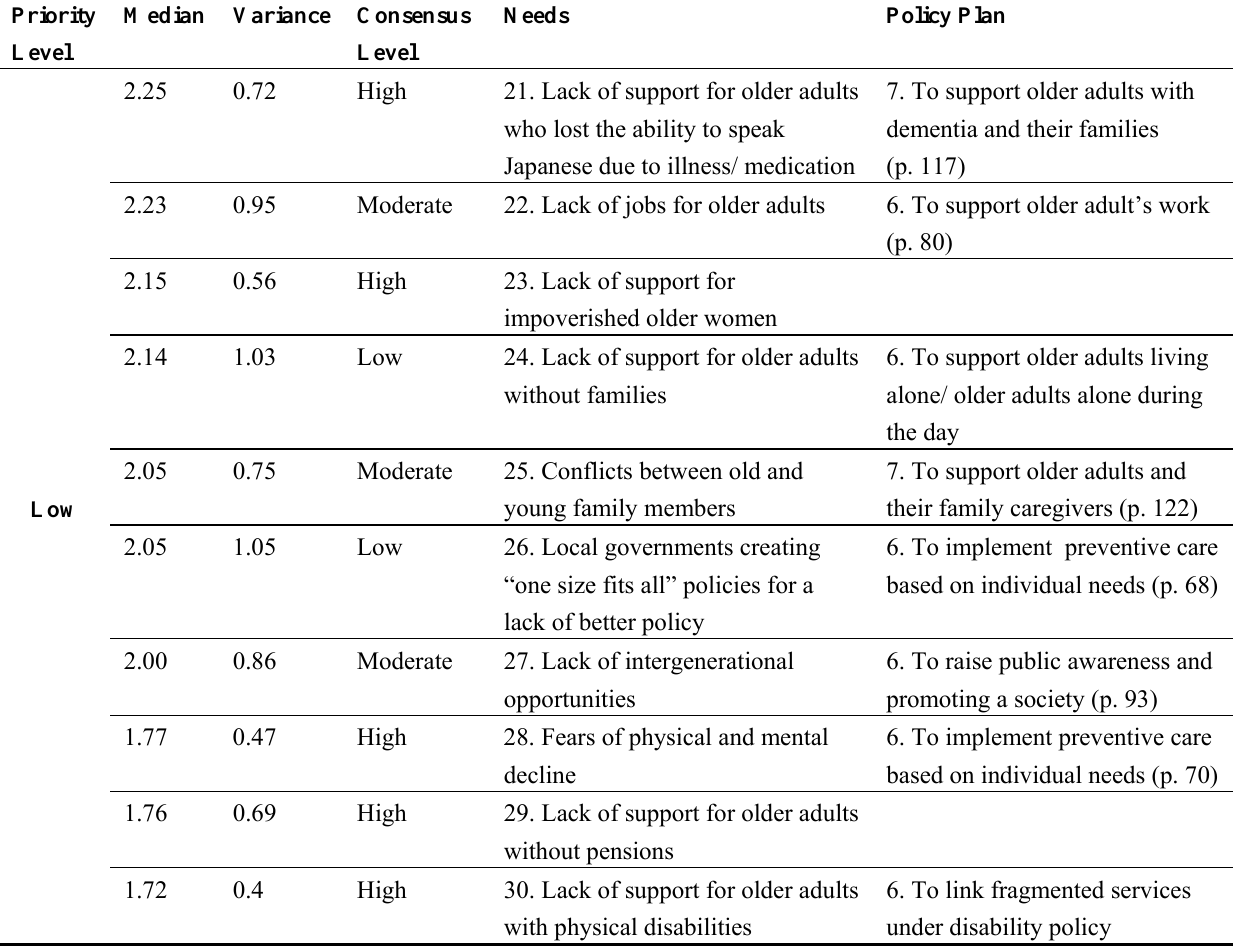
Table 4. Low priorities, levels of consensus, and corresponding city’s policy plan for 30 needs identified from focus group interviews with ethnic Chinese